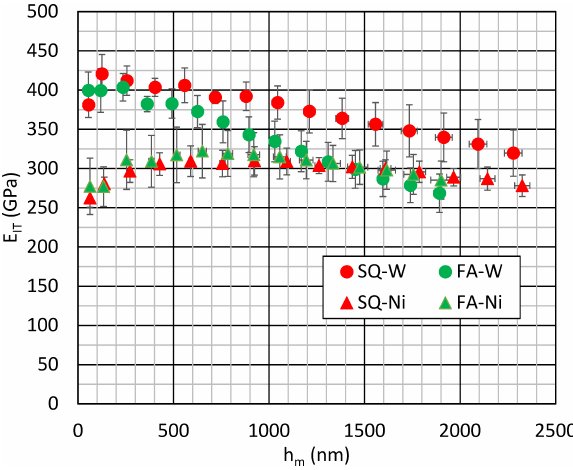
Figure 6. Elastic modulus of W particles and Ni matrix determined by instrumented indentation by Berkovich indentor for different penetration depths h m